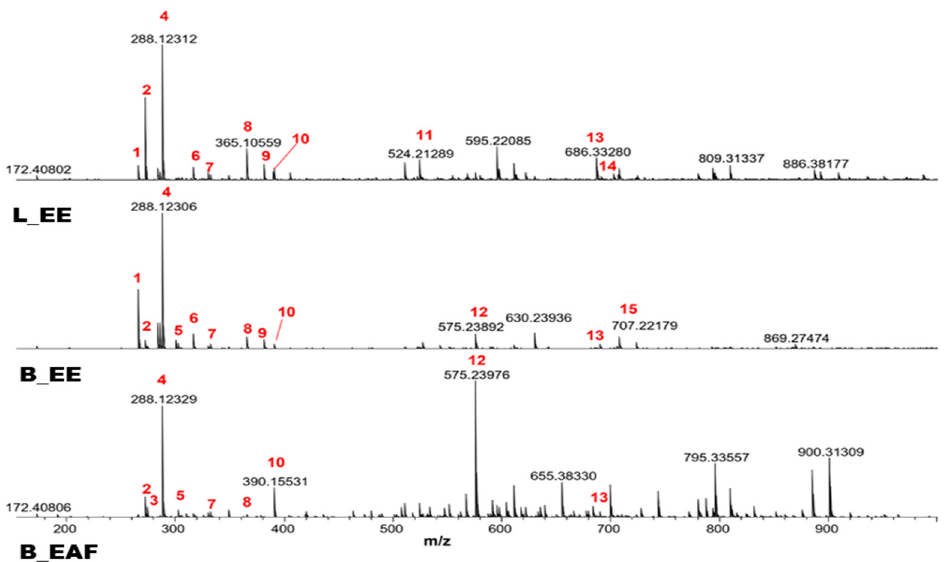
Figure 2. ESI (+) FT-ICR MS spectra of L_EE, B_EE, and B_EAF extracts of Crinum americanum L. (Amaryllidaceae). The identification of compounds according to the numbering in this figure is outlined in Table 2.